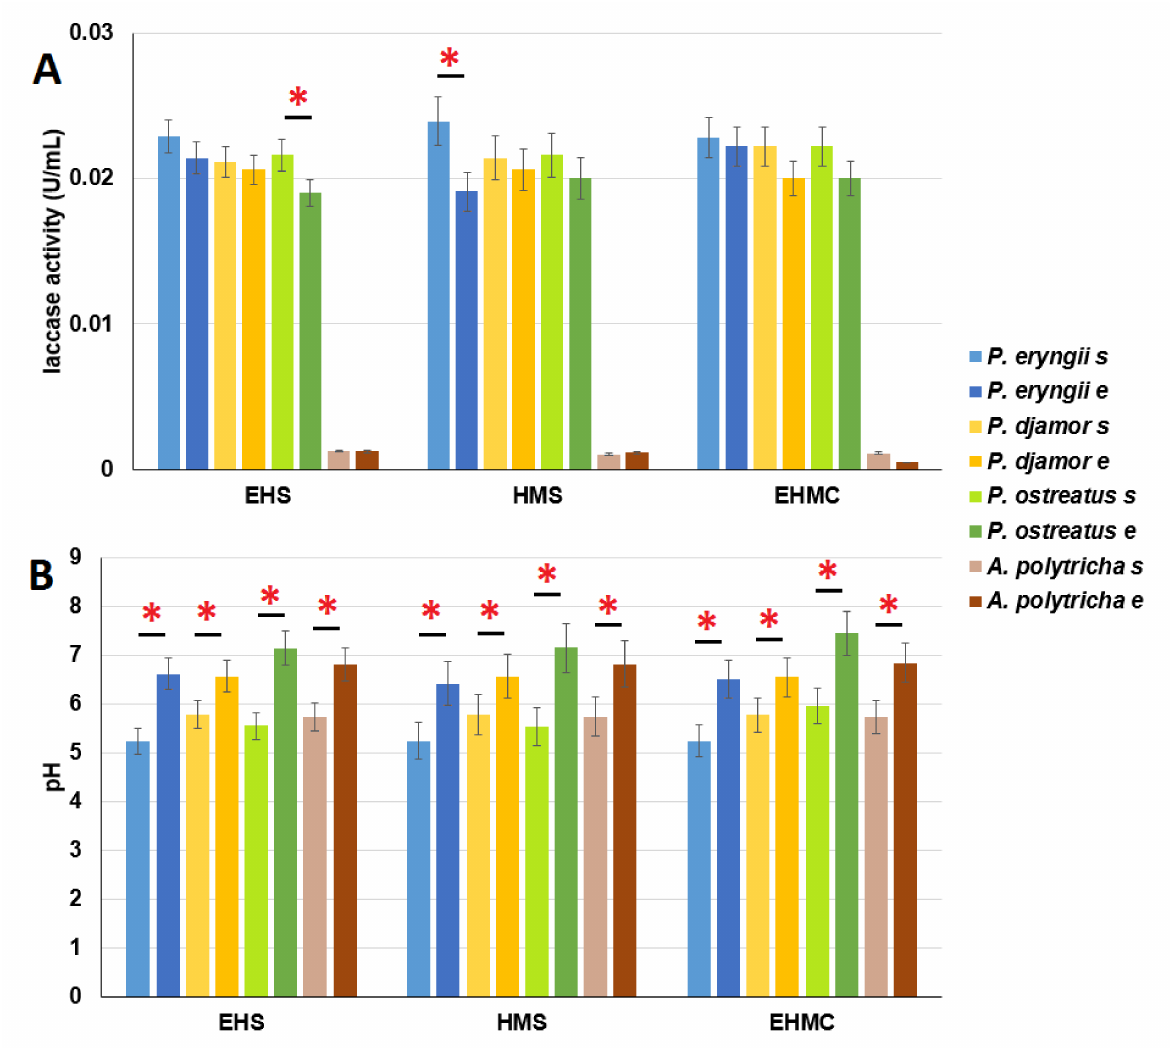
Figure 4. ( A ) Laccase activity and ( B ) pH values of the enzyme extracts before and after batch experiments. Data from triplicate experiments are presented as the mean ± SE. s: start of experiments, e: end of experiments. EHMC: ethylhexyl methoxycinnamate, EHS: 2-ethylhexyl salicylate, HMS: homosalate. Red stars indicate the p values of t tests <